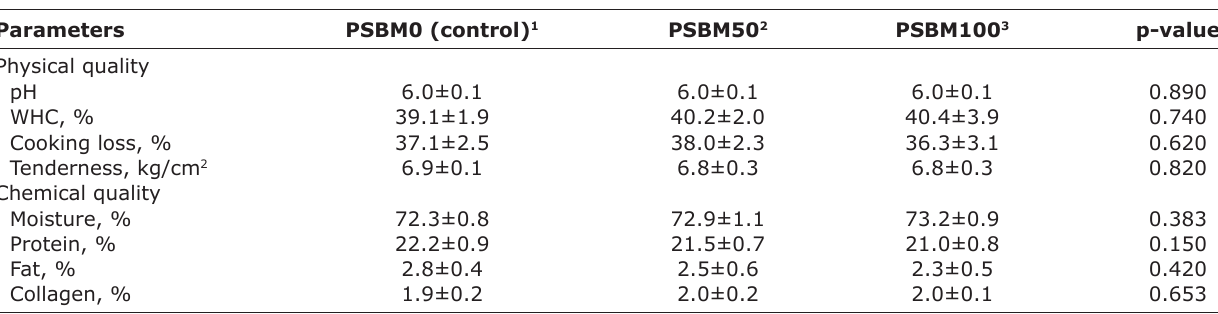
Table-4: Physical and chemical quality of the chevon.